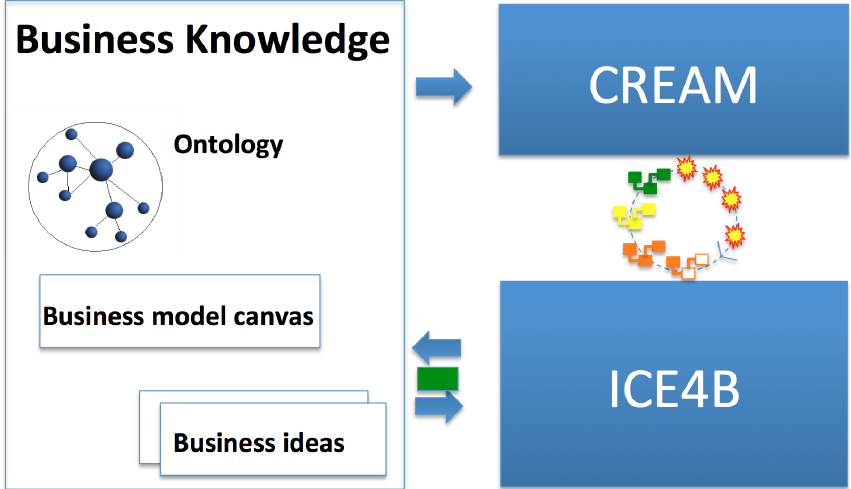
Figure 3. Architecture of the gamified software including CREAM (CREAtivity Machine), ICE4B (Innovation through Collaborative Environment for Business), and a business knowledge